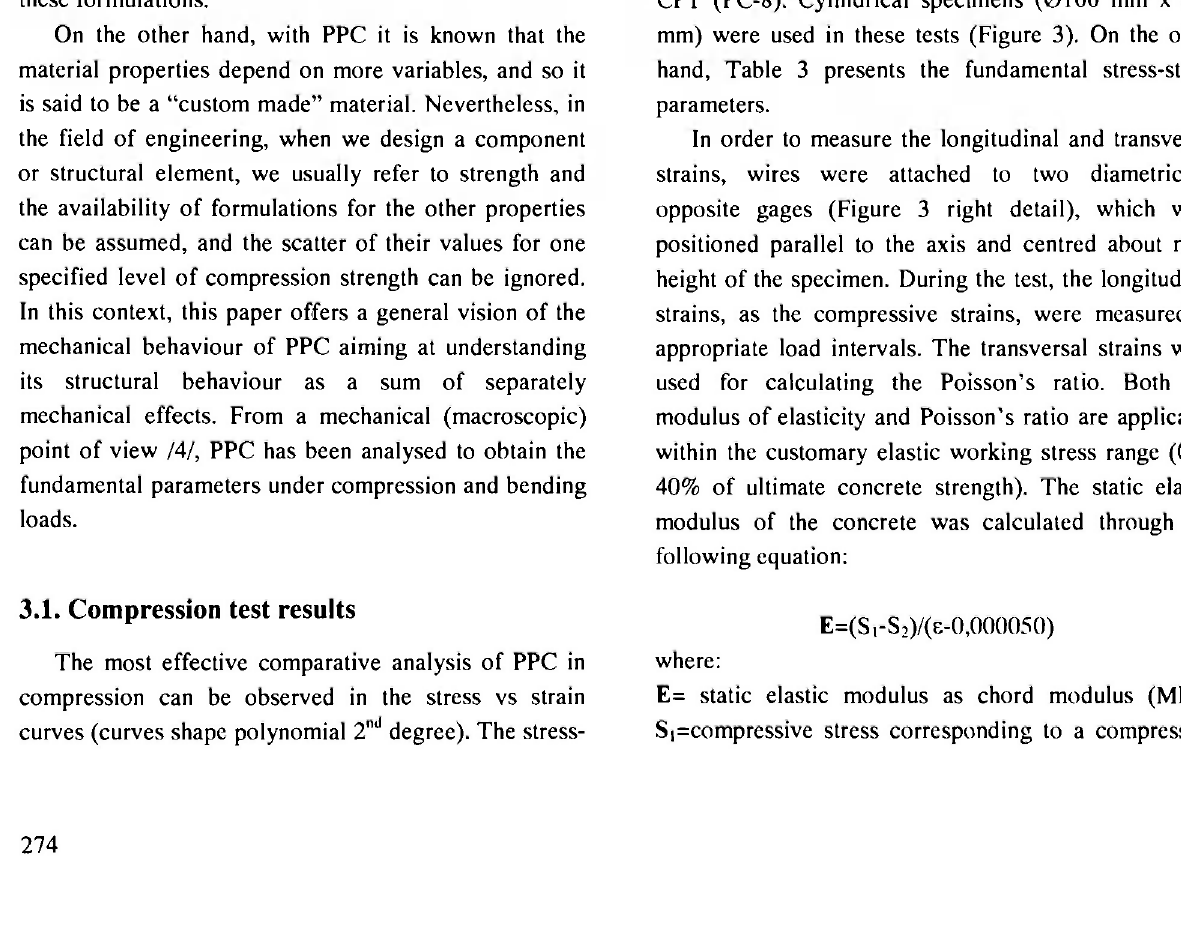
Fig. 2: SEM microphotograph of PPC